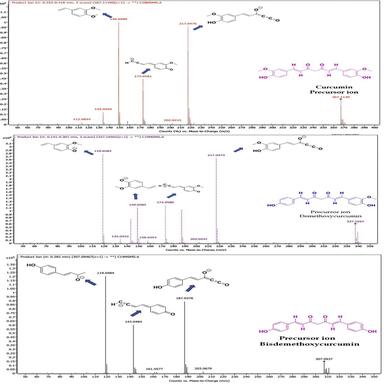
HR-MS/MS spectrum of curcumin, desmethoxycurcumin, and bisdemethoxycurcumin.